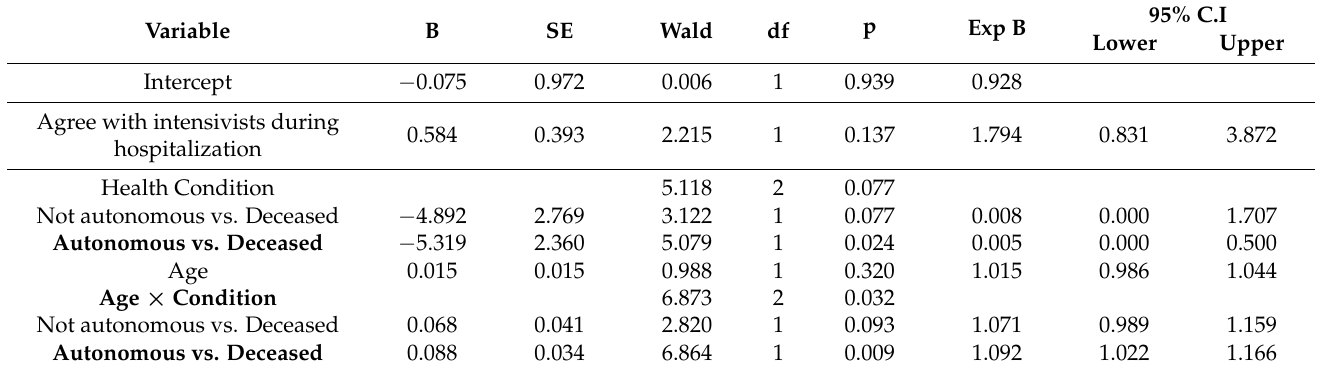
Table 7. Effects of patients’ characteristics on family/patient selection in the two theoretical scenarios.